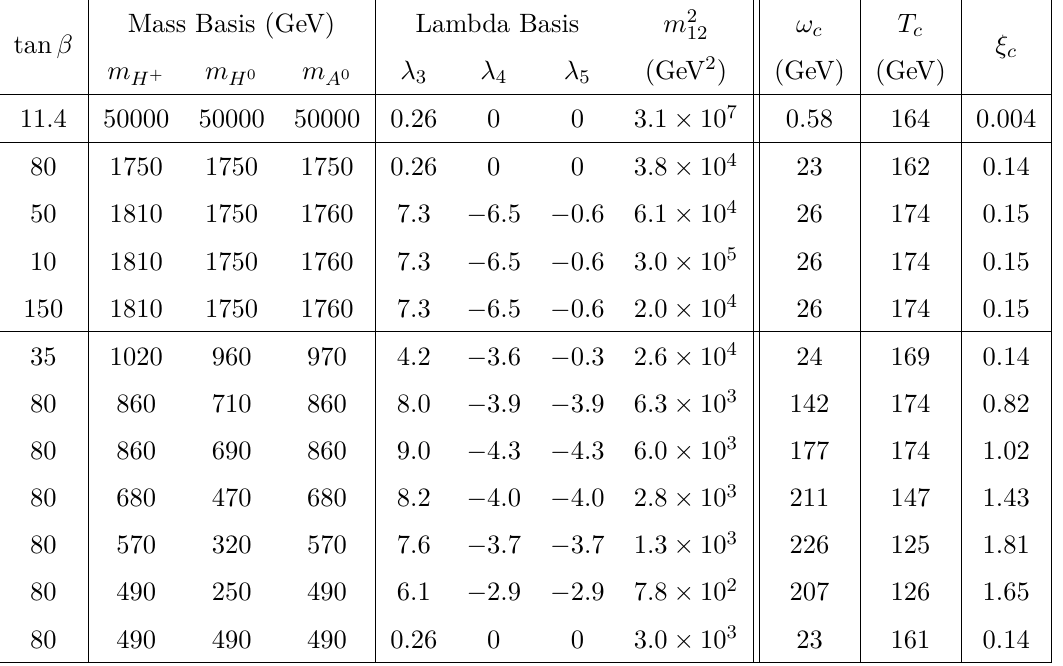
Table 5 . Table of results for the EWPT in the 2HDM-I. ξ c = ω c /T c is the parameterisation of the strength of the EWPT, with ω c the high-temperature VEV and T c the critical temperature. A SFOEWPT is indicated by ξ c > 1 . In the limits chosen in ref. [13] (and similarly discussed